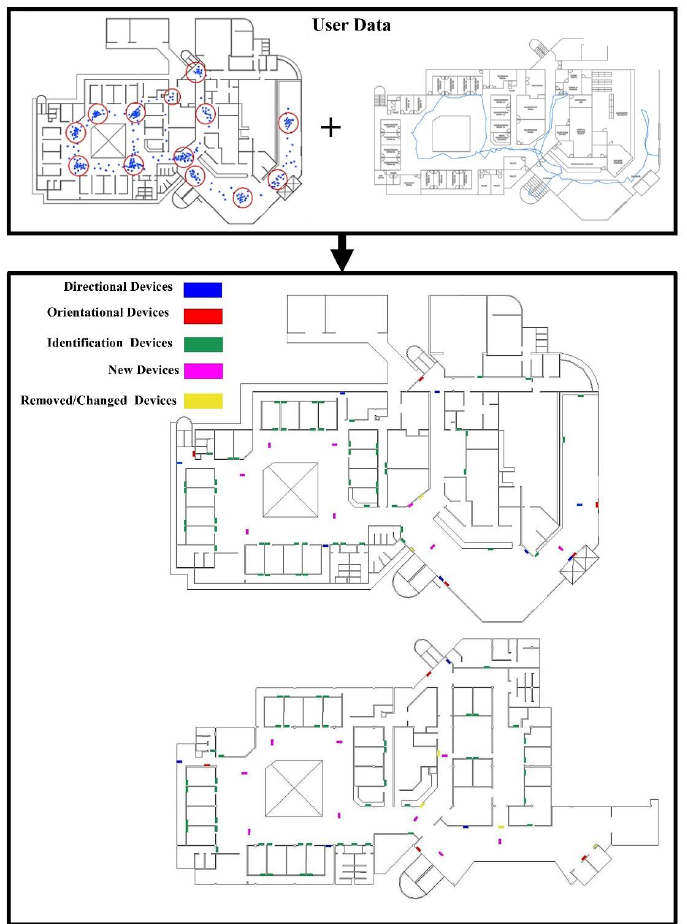
Figure 6. The distribution and type of way-showing devices and an example of the user data its based upon . While subjects ’ selected paths are registered through real-time tracking of users ’ nav- igation routes, users ’ pausing points are registered on the floors ’ layouts. Pausing points indicate areas of decision making or confusion. The same procedure then applied for the second set of users going through the virtual experiment with wayfinding items located at the spaces where decision making points are located at the first VRE. Both sets of data were then analysed and compared to indicate the effectiveness of the revised wayfinding system in which the newly developed signage system is based upon. See Figure 6. 2.2.4. Virtual Experiment User Control, Instruction, and Information Display The user controls were set to be a keyboard and a mouse-based control due to its popularity amongst computer users, especially in the users ’ control of video games where